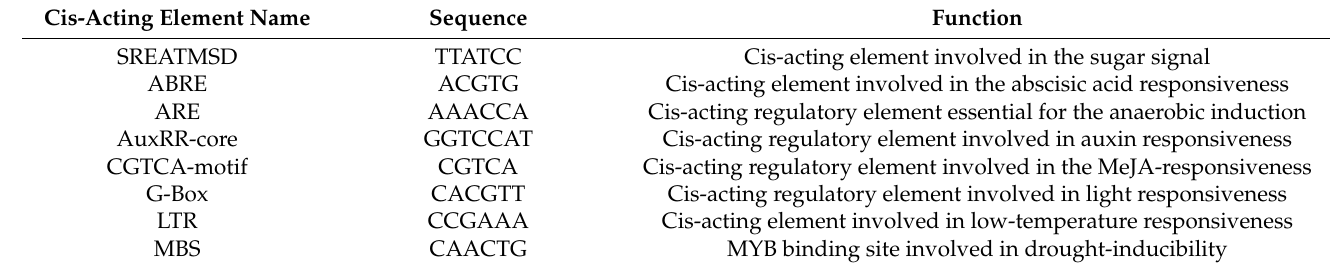
Table 4. Analysis of some important cis-acting regulatory elements in the promoter sequences of PgSWEET17a .